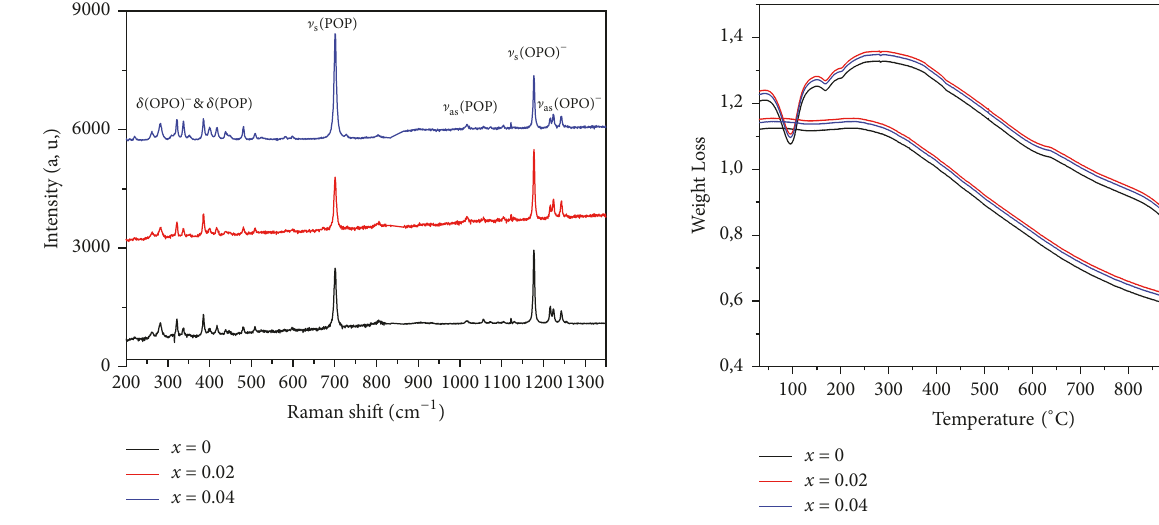
Figure 5: Raman spectra of LiGd(PO 3 ) 4 (x=0, 0.02 and 0.04) at 300 K. Table4:AttributionsofmainIRbands(cm - 1 )ofLiGd (1 samples.